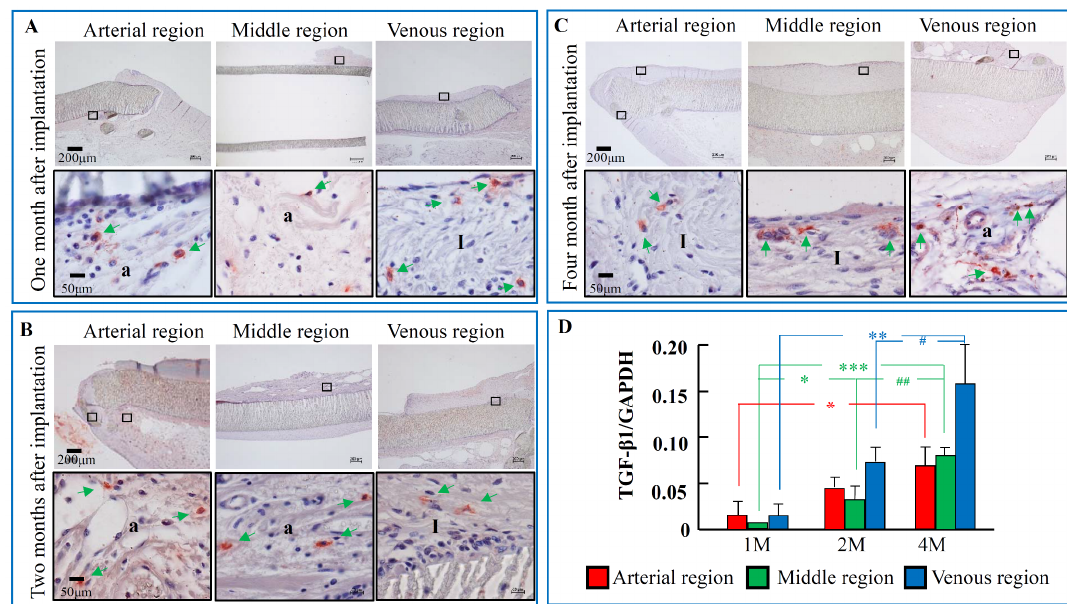
Figure 3. Immunostaining pattern and mRNA expression level of TGF-β1 during the 4-month post-PTFE graft implantation period. ( A – C ) Representative TGF-β1 immunostaining at the different regions of PTFE grafts 1, 2, and 4 months after PTFE graft implantation. ( D ) Time-dependent changes of TGF-β1 mRNA expression levels 1, 2, and 4 months after the PTFE graft implantation. I: intima side; a: adventitial side. Green arrows: TGF-β1-positive cells. Each bar represents the mean ± S.E.M. of six grafts. * p < 0.05, ** p < 0.01, *** p < 0.001 vs 1 M; # p < 0.05, ## p < 0.01 vs 2 M.